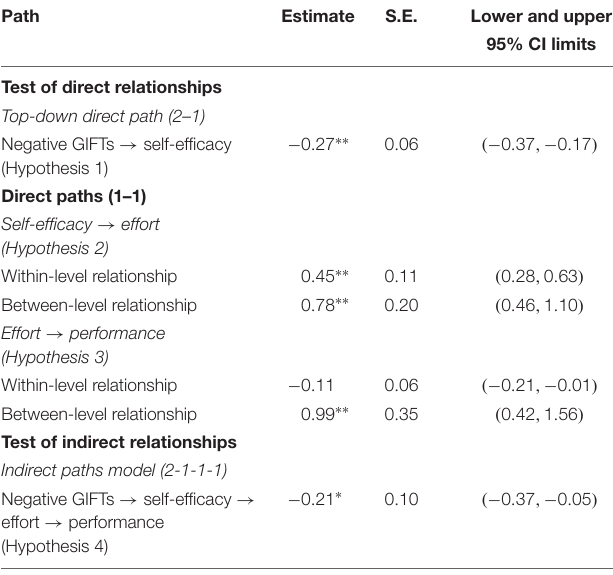
TABLE 2 | Tests of direct and indirect relationships (Hypotheses